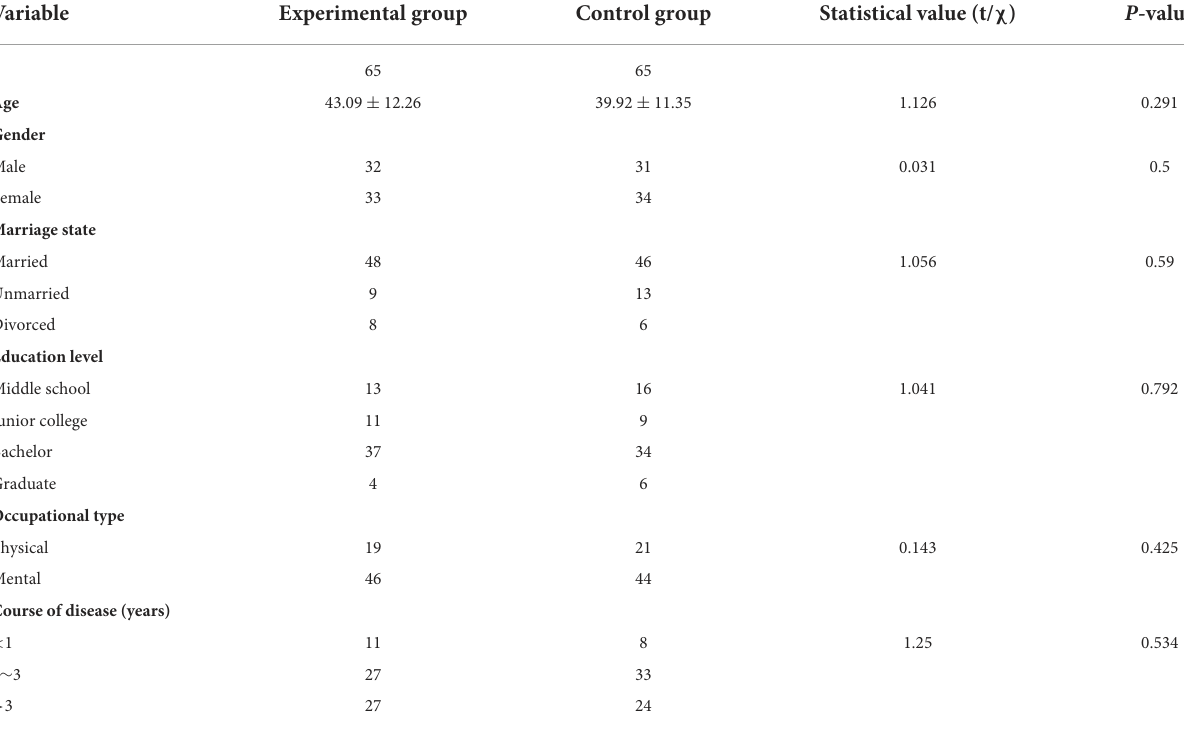
TABLE 1 Comparison of baseline data between the two groups. Variable Experimental